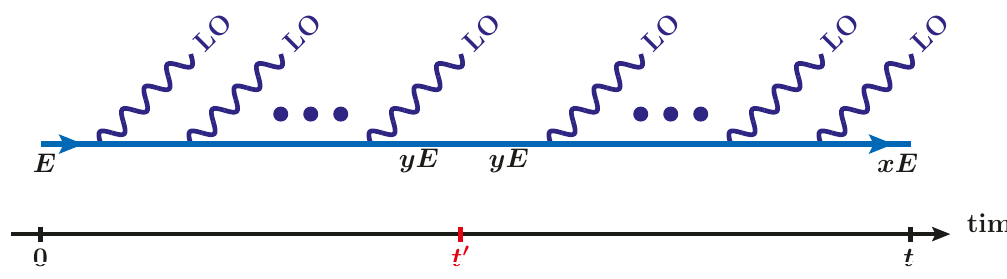
Figure 19 . Like (cid:12)gure 18 but showing a case where (randomly) all of the splittings are leading- order splittings. To evaluate its probability, we must combine the probabilities that in each tiny time interval [ t 0 ; t 0 + dt 0 ] there was no NLO